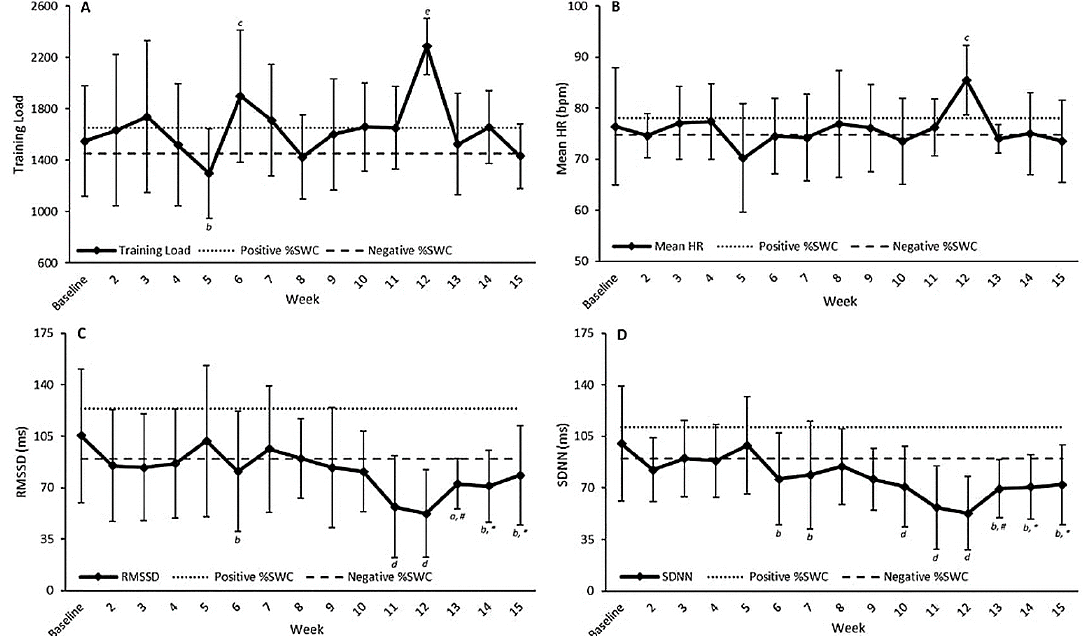
Figure 1. Changes from baseline over the 15-week monitoring period for ( A ) training load, ( B ) mean heart rate, ( C ) root mean square of successive RR interval differences (RMSSD), and ( D ) the standard deviation of all normal to normal RR intervals (SDNN). Data are presented as means ± SD, with dashed lines representing the positive and negative percentage smallest worthwhile change (%SWC, 3%) from baseline [31]. a indicates possibly lower compared to baseline. b indicates likely lower compared to baseline. c indicates likely higher compared to baseline. d indicates very likely lower compared to baseline. e indicates very likely higher compared to baseline. * indicates likely higher compared to week 12. # indicates very likely higher compared to week 12.